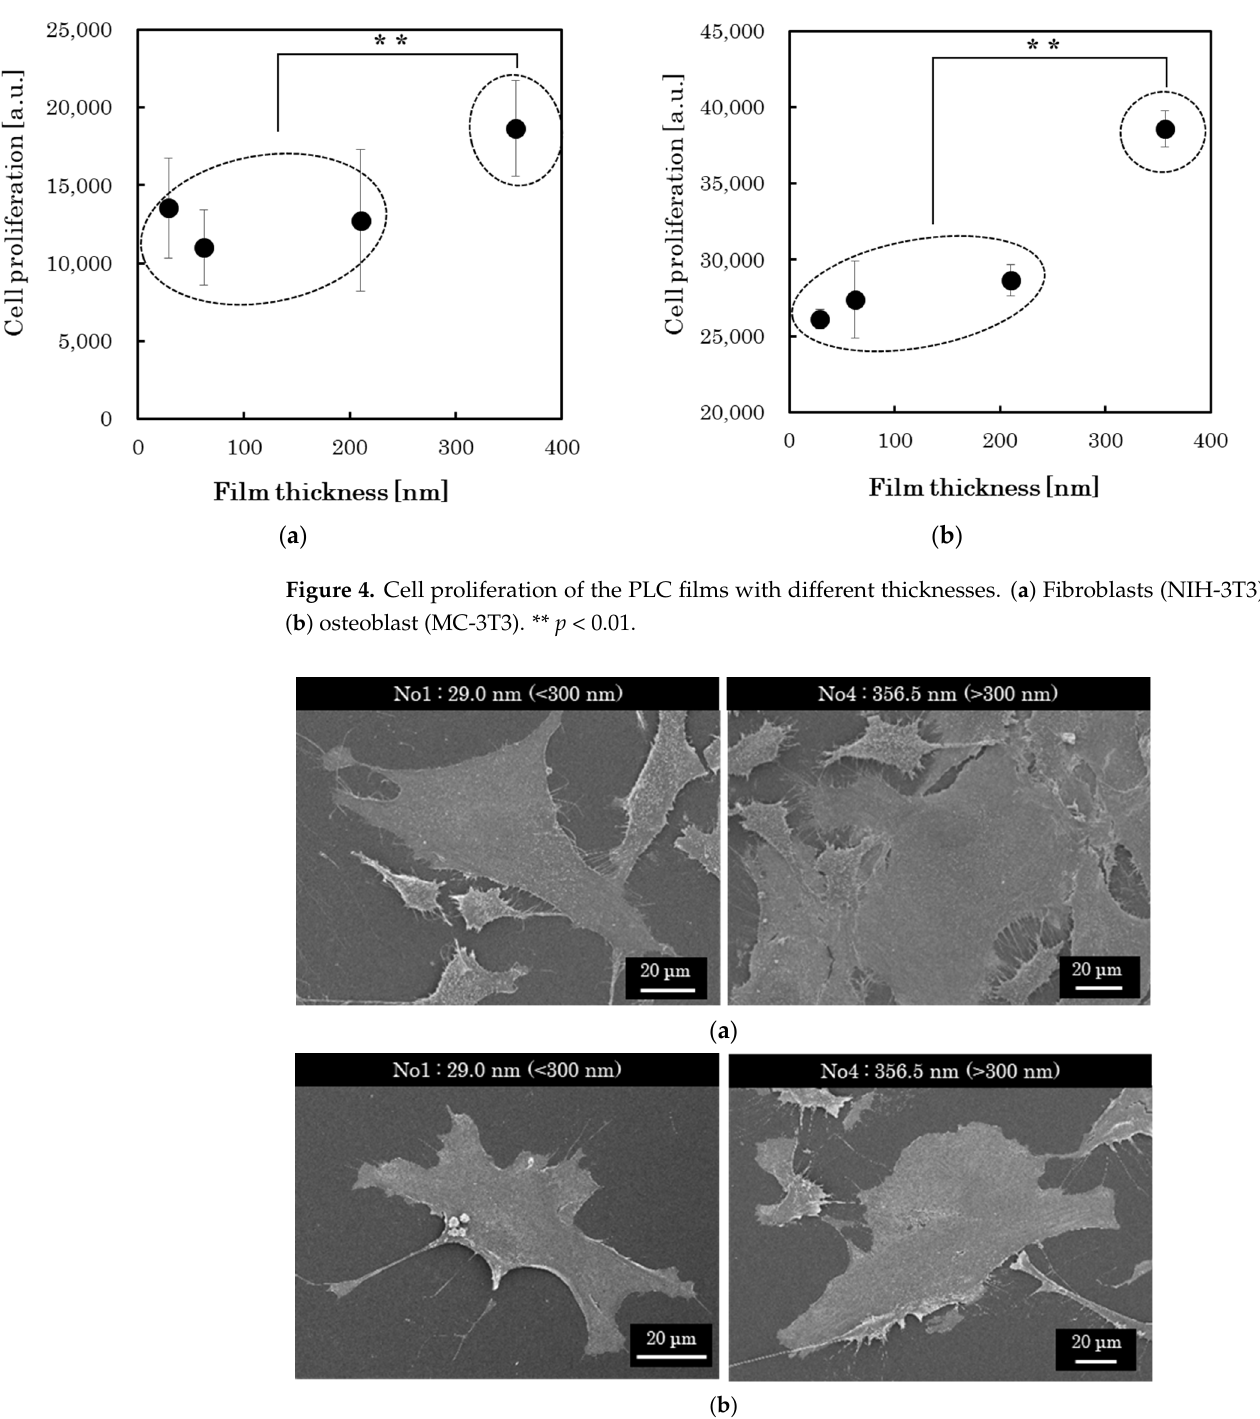
Figure 5. Cell morphology images of relatively thick (>300 nm) and thin (<300 nm) PLC films. ( a ) Fibroblasts (NIH-3T3); ( b ) osteoblast (MC-3T3).